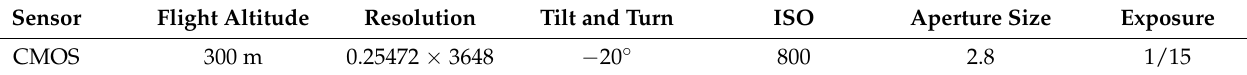
Table 1. UAV parameter settings.